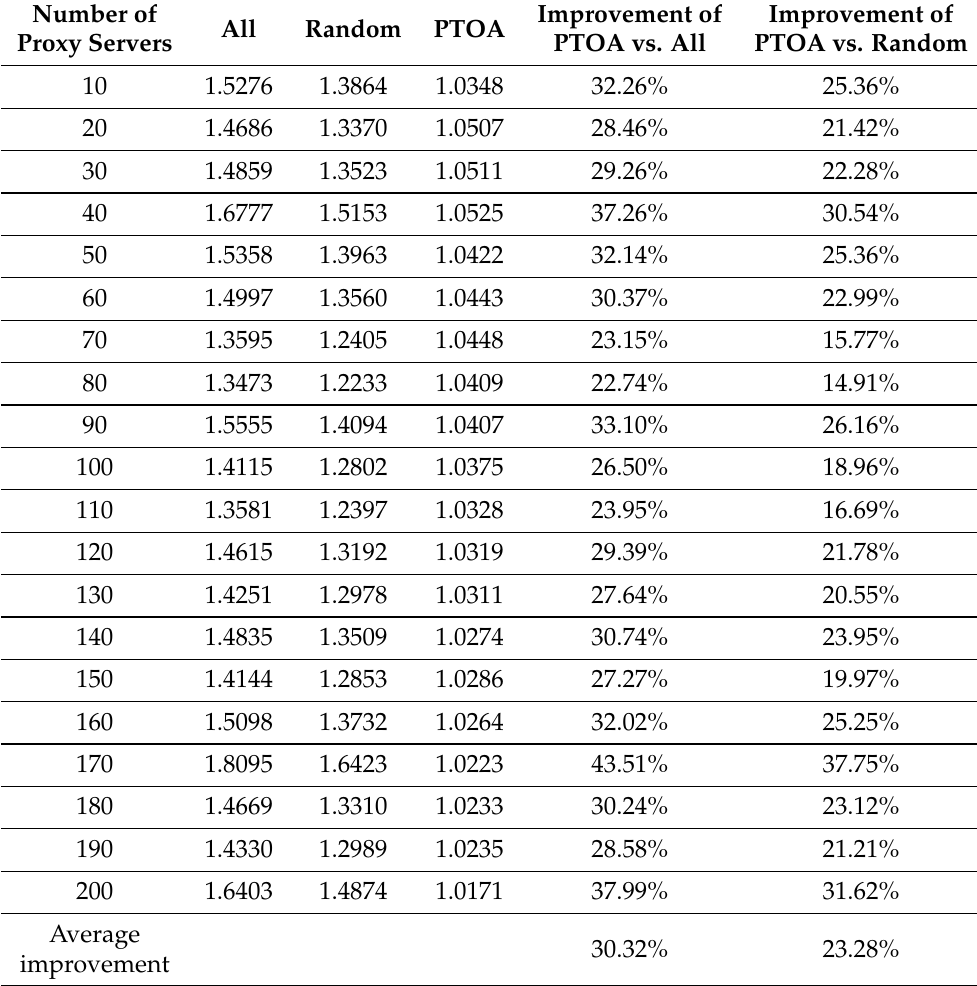
Table 4. Comparison of the location privacy-preserving ability of PTOA with the methods All and Random with different numbers of proxy servers.